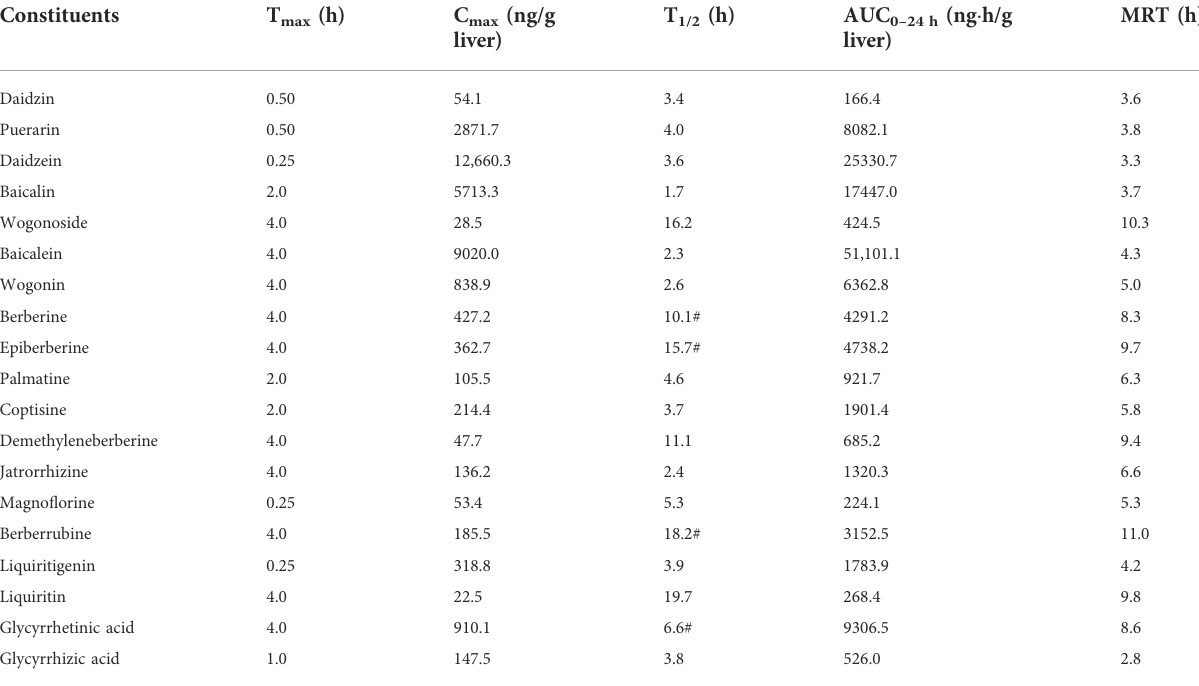
TABLE 5Pharmacokineticparameters oftheconstituentsin theliversof themice receivedthe oral Gegen - Qinlian decoction extract at thedosage of 6.1 g/kg (mean ± SD, n = 6).